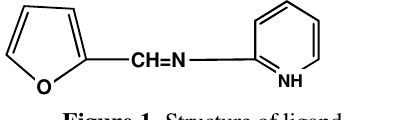
Figure 1. Structure of